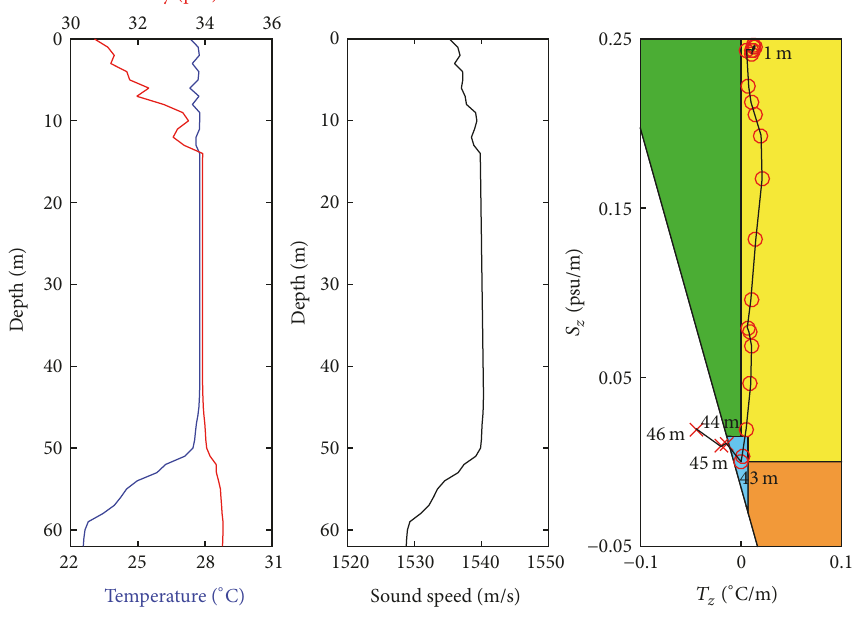
Figure 3: Cold surge